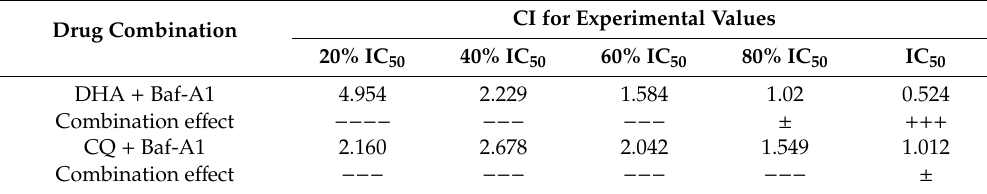
Table 3. Combination index values and e ff ects of DHA / CQ with Baf-A1 against P. f 3D7 in vitro. Drug Combination